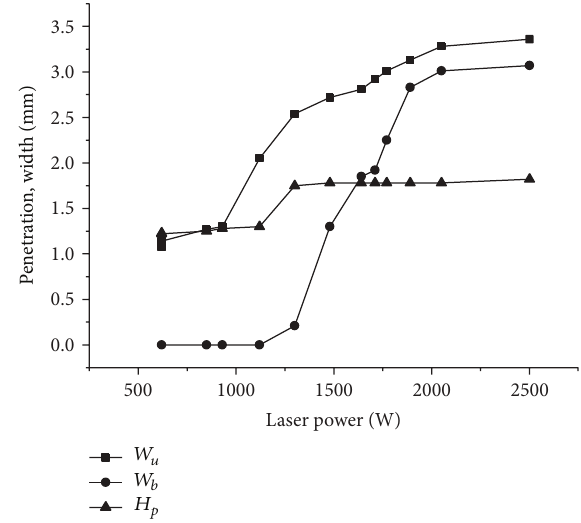
Figure 2: Influence of laser output power on width and penetration of welded seam. ( Δ𝑍 = 0 mm; 𝑉 = 1.5 m/min; 𝑈 𝑓 = 15L/min).